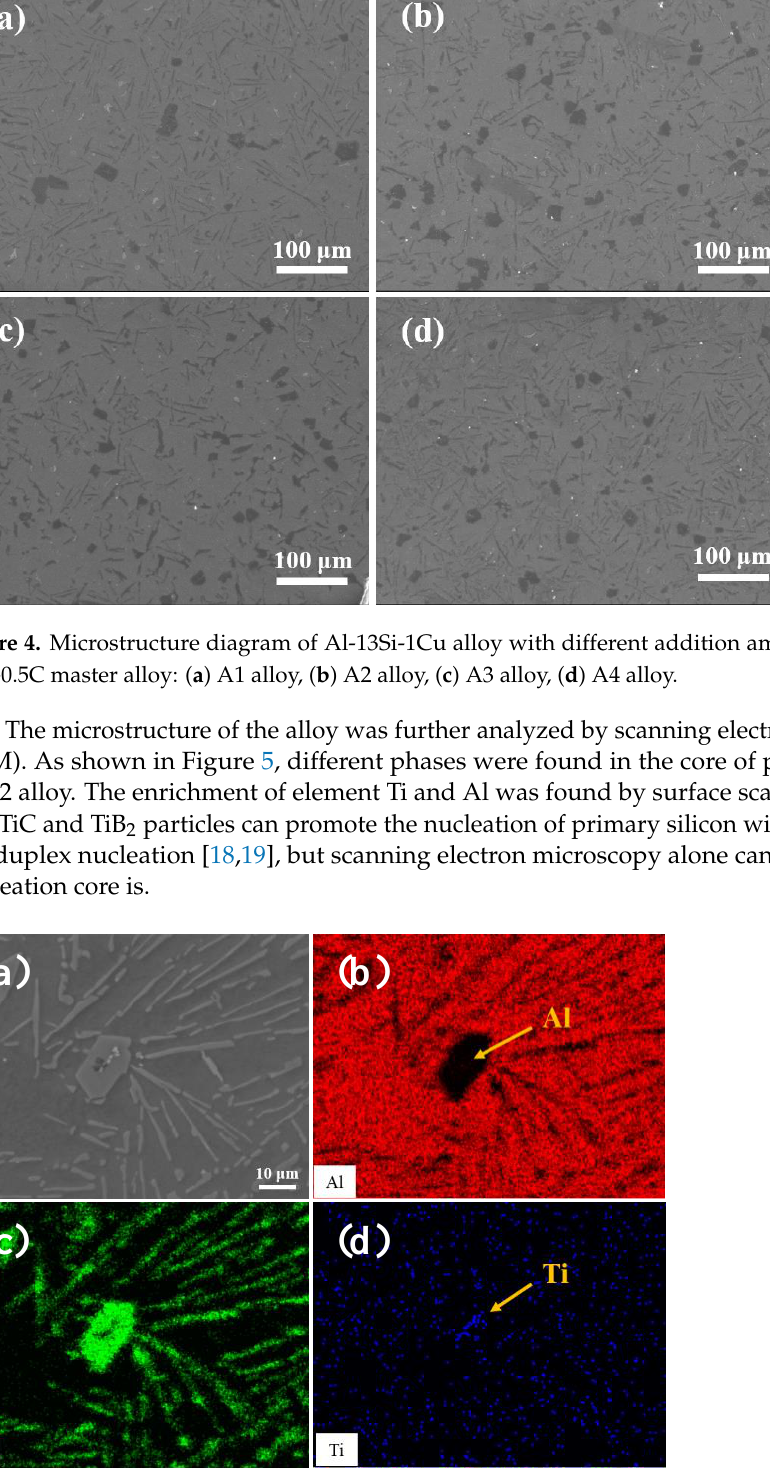
Figure 5. Element distribution at the primary silicon of the A2 alloy. ( a ) Morphology of primary Si, ( b ) Al element, ( c ) Si element, ( d ) Ti element.